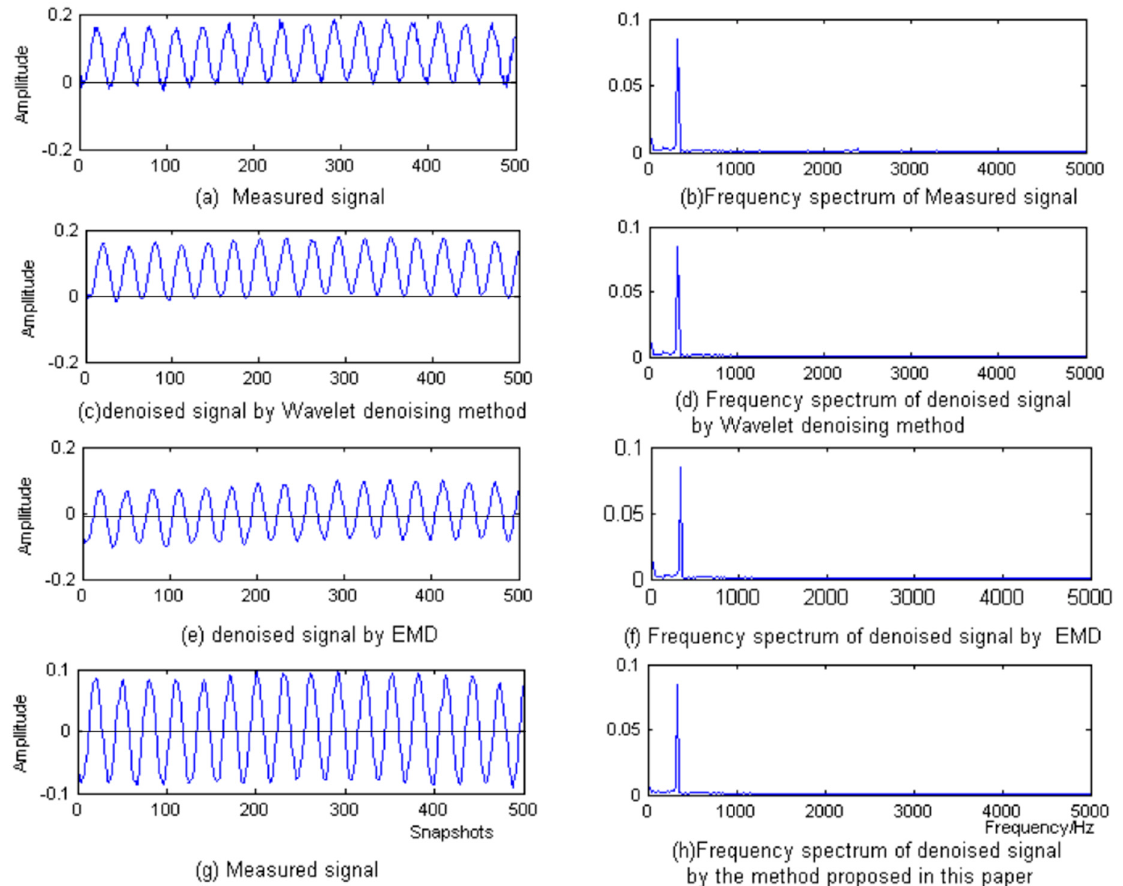
Figure 3. Signal denoising contrast result. ( a ) The measured hydroacoustic signal. ( c ) The denoised signal from wavelet threshold method. denoising result, ( e ) The denoised signal from empirical mode decomposition. ( g ) The denoised signal from the proposed method. ( b , d , f , h ) are the spectrum analysis for ( a , c , e , g ),